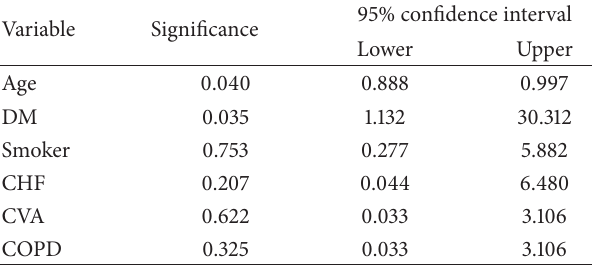
Table 4: Multivariate analysis ( P value) of risk factors related to MDR- Pseudomonas